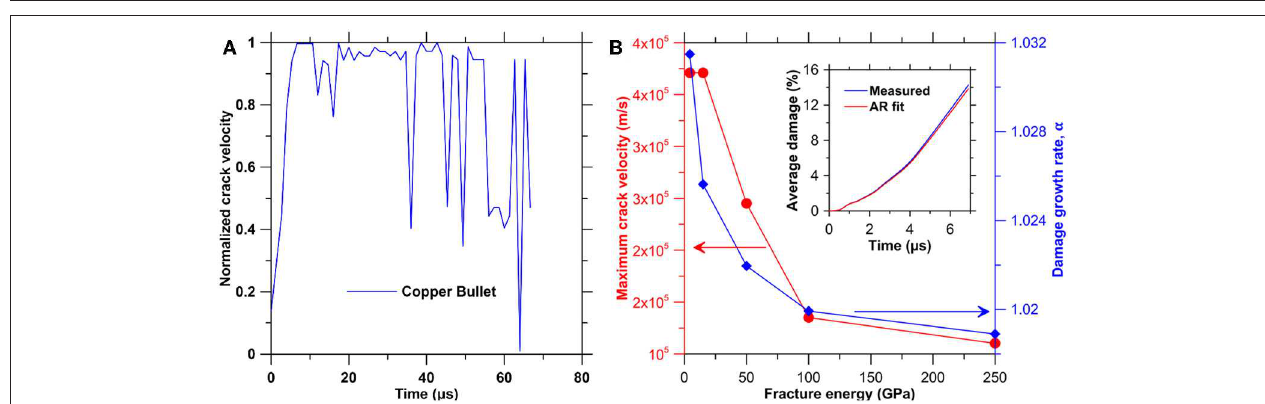
FIGURE 8 | (A) Distribution of cracks in the glass plate in a polar coordinate system, (B) histogram of the distribution of cracks with respect to the angular position θ . Note that the peaks indicate the major radial cracks.